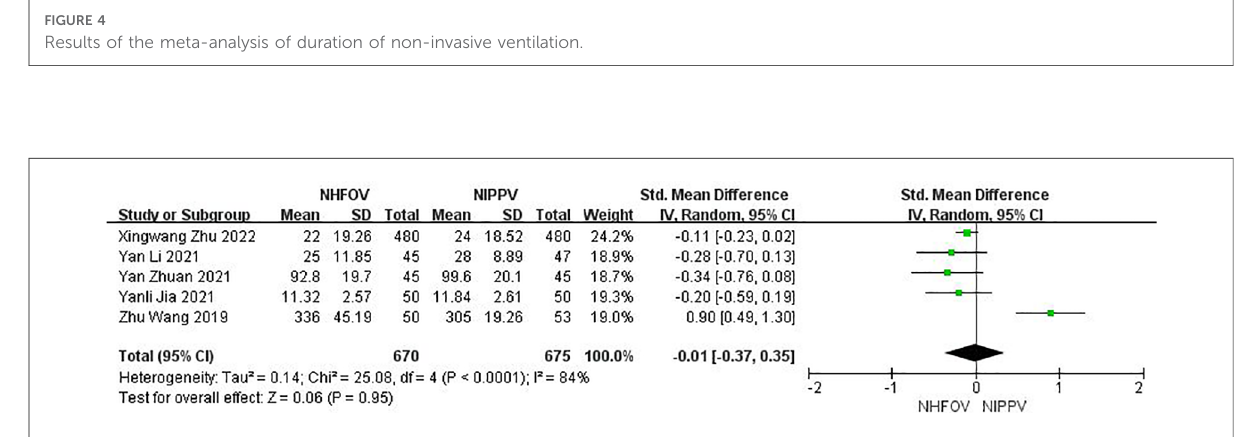
FIGURE 5 Results of the meta-analysis of total oxygen therapy